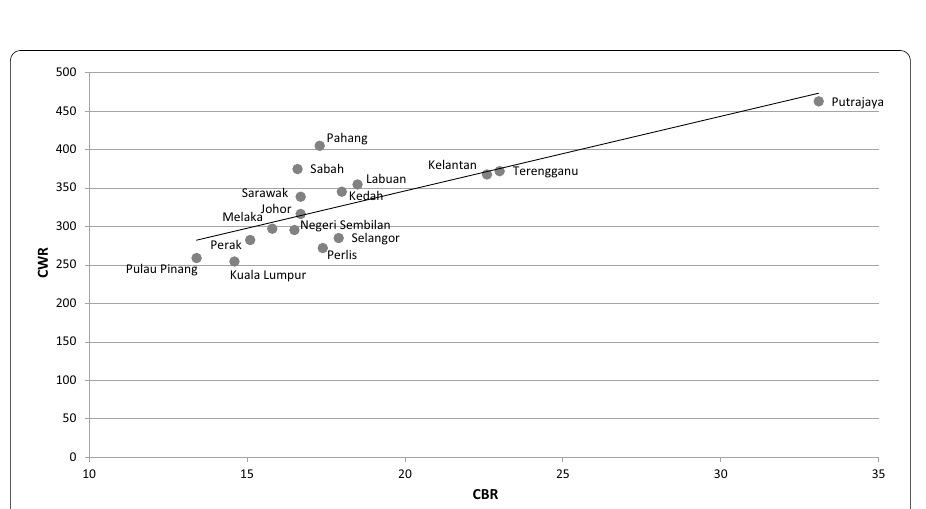
Fig. 7 CBR and CWR in ASEAN countries, 2010. Spearman correlation coefficient World population prospects 2019 (UN, 2019)